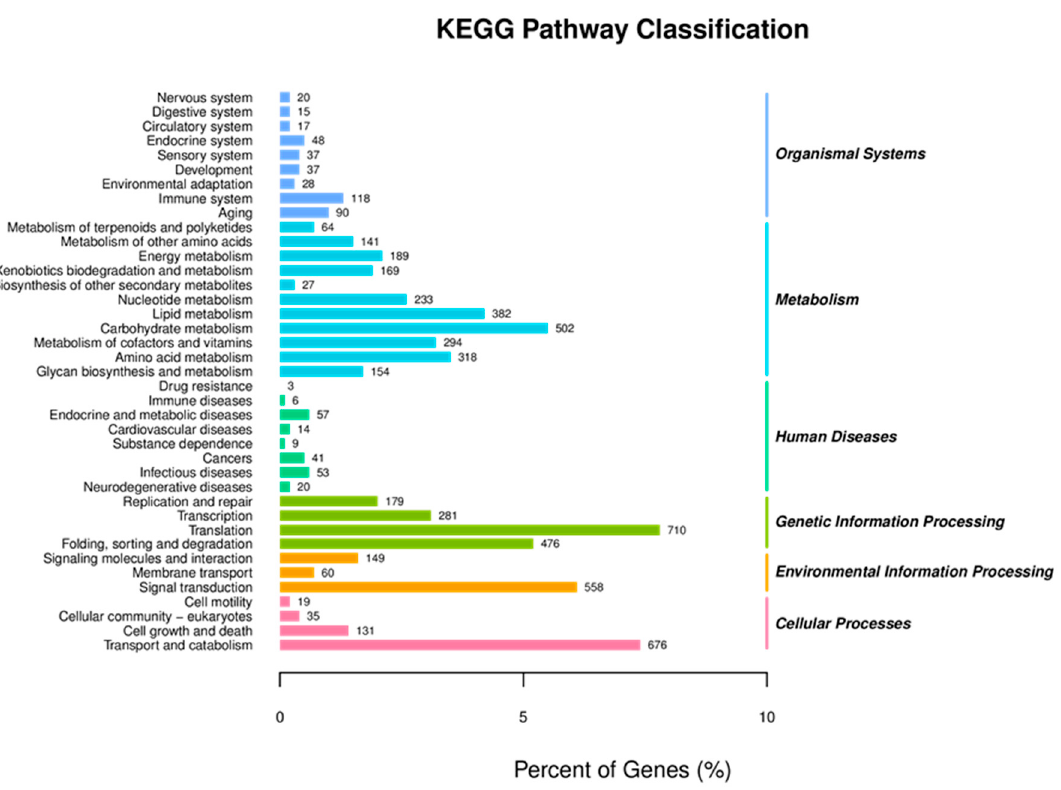
Figure 4. Kyoto Encyclopedia of Genes and Genomes (KEGG) annotation and pathways of the Spodoptera frugiperda tran- scriptome.